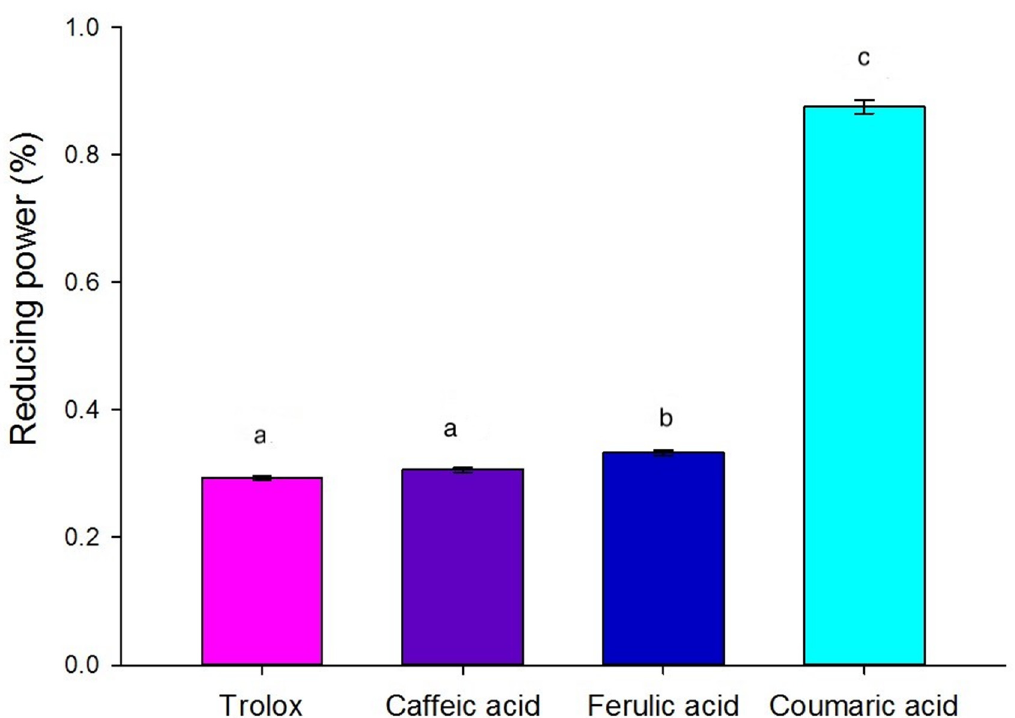
Figure 3. Percentage of reducing power of Pericarp comparison with Trolox, caffeic acid, ferulic acid, coumaric acid (0.1 M). Values reported as percentage (%). Values presented are the average of three replicates ± standard deviation. Different letters indicate that the values are significantly different ( p < 0.05).